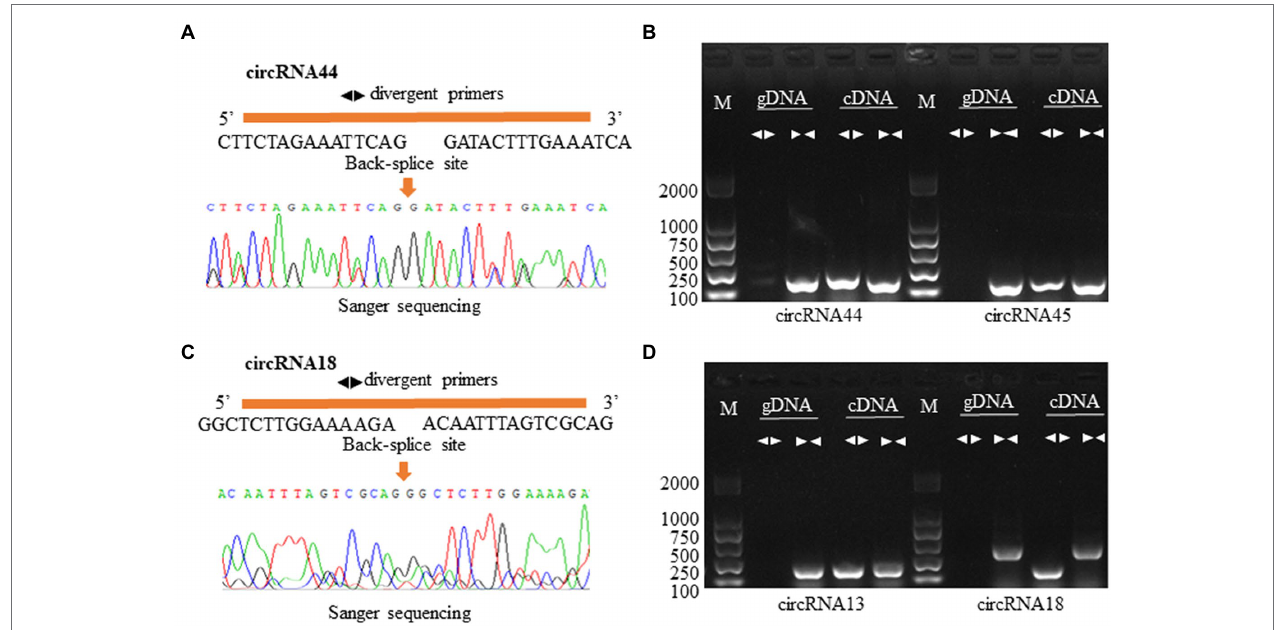
FIGURE 2 | Validation of circRNAs in the roots of P. X canescens. (A,C) A detailed depiction of two circRNA circularization and Sanger sequence validation using divergent primers. (B,D) PCR amplification results for four predicted circRNAs in cDNA and genomic DNA samples. Convergent and divergent primer sets worked on both cDNA and genomic DNA. M: